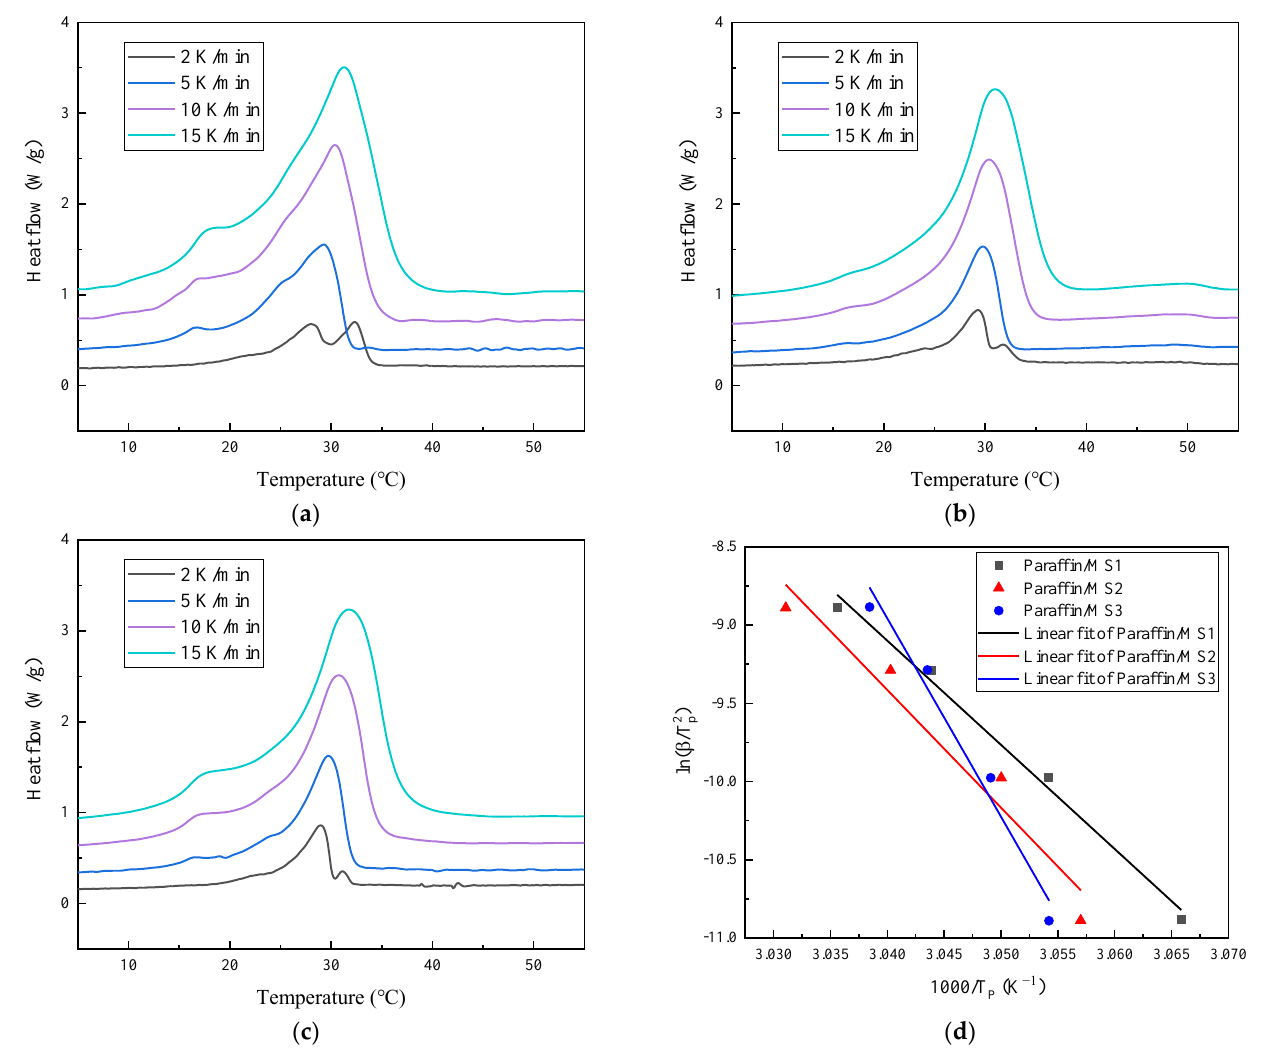
Figure 7. Data for activation energy calculations: ( a ) DSC results for paraffin/MS1 SS-PCM at different heating rates, ( b ) DSC results for paraffin/MS2 SS-PCM at different heating rates, ( c ) DSC results for paraffin/MS3 SS-PCM at different (cid:18) (cid:19) β heating rates, ( d ) the linear fitting of ln vs. 1000 based on the Kissinger T p T 2 p